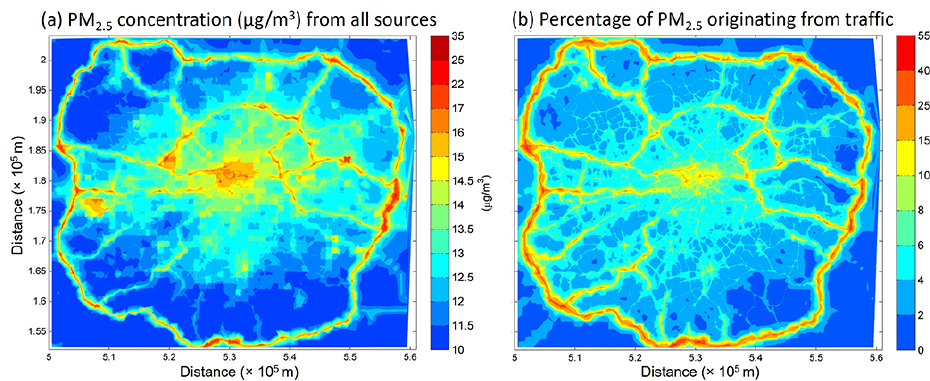
Figure 10. (a) Predicted spatial distributions of the annual mean PM 2 . 5 concentrations in µgm − 3 , and (b) urban traffic contributions to the total PM 2 . 5 concentrations, in %, for London for the year 2008 (Singh et al.,